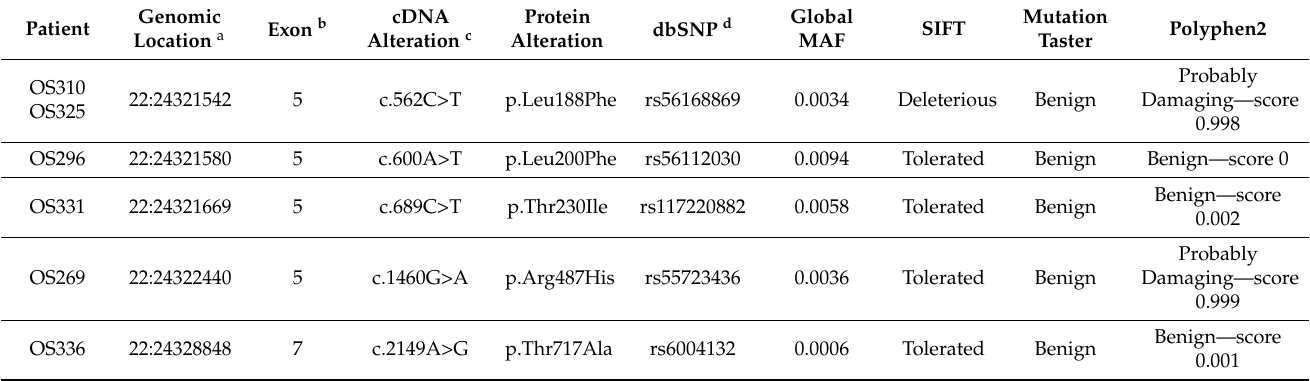
Table 2. Missense variants identified in the SPECC1L gene.